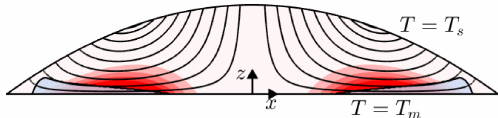
Figure 6. Ice cap setup. Solid lines show ice streamlines, red shad- ing shows the magnitude of viscous dissipation, and blue shading shows the region of temperate ice (to be found). Here Z b (x) = 0m and Z s (x) = 1500 ( 1 − (x/L) 2 ) m, with L =